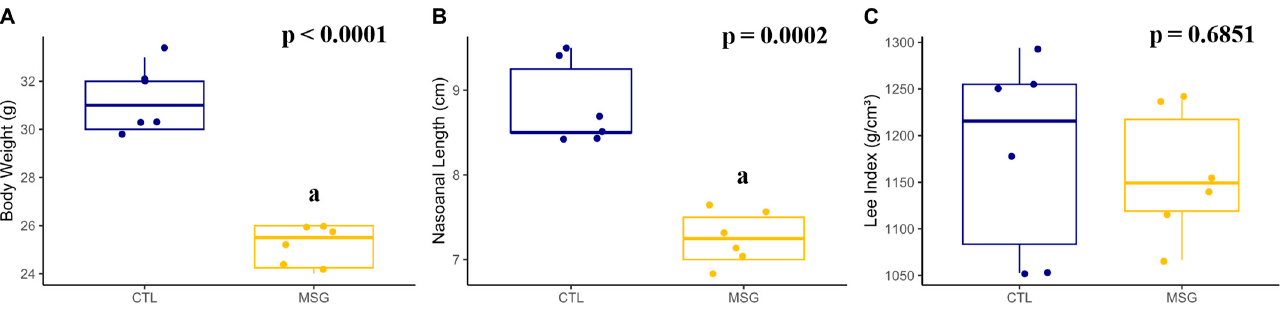
Figure 4. Graphs related to corporal characterization in PND15: ( A ): body weight (g); ( B ): nasoanal length (cm); ( C ): Lee index (g/cm 3 ). The CTL is represented in blue and the MSG group is represented in yellow. The letter a represents the difference between the MSG group when compared to the CTL. All data: Student’s t -test.